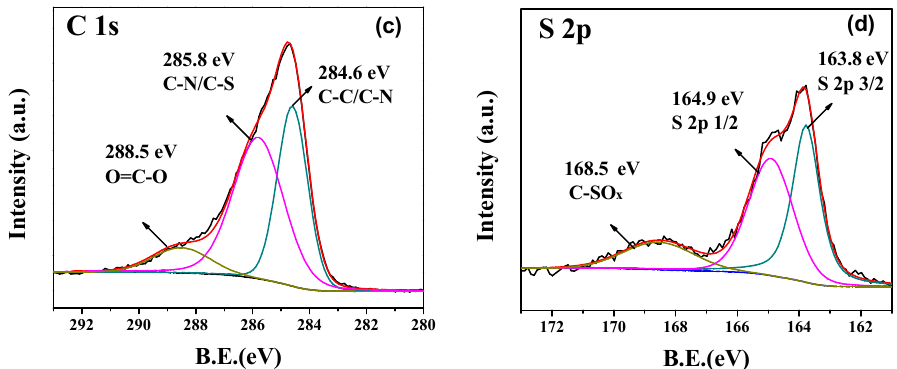
Figure 2. ( a ) XPS spectra of S/ONPC composite, ( b ) N1s XPS spectrum of the S/ONPC composite, ( c ) C1s XPS spectrum of the S/ONPC composite, ( d ) S2p XPS spectrum of the S/ONPC composite.